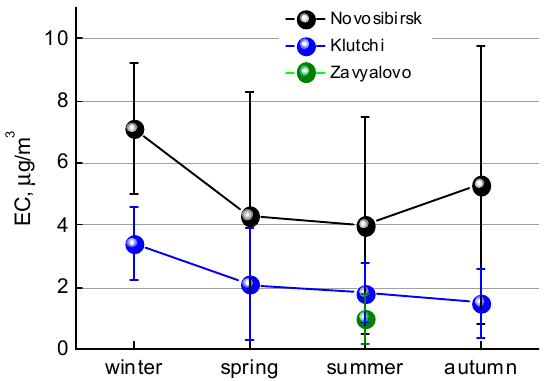
Figure 5. Annually averaged behavior of EC concentration and its SD in Novosibirsk (urban center), Klutchi village (suburban) and Zavyalovo village (background; 2000–2016).